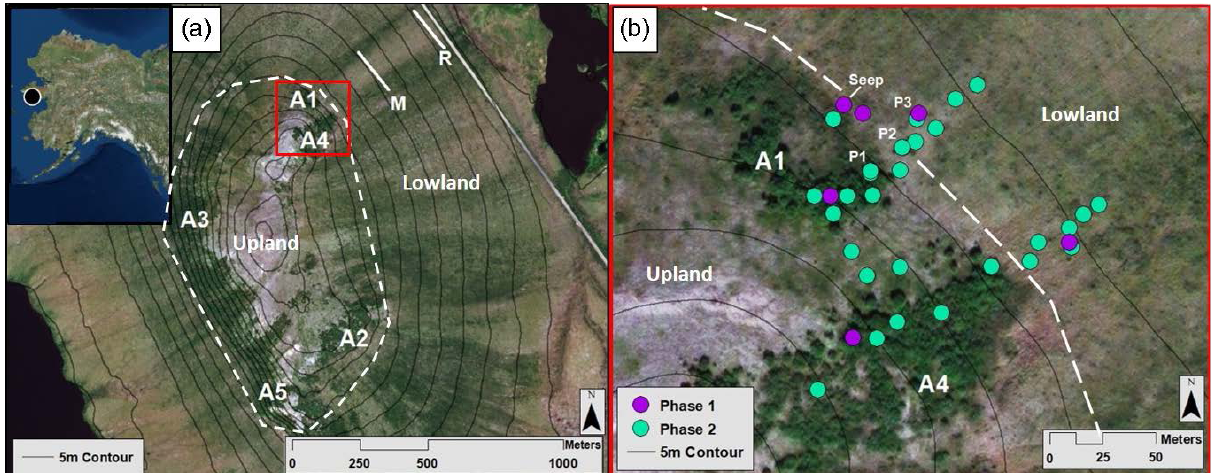
Figure 1. The Kougarok field site and sampling locations. Upper left inset map indicates the location of the Kougarok field site (denoted by a black circle) approximately 80km inland from the town of Nome on the Seward Peninsula, AK. (a) Alder patch and transect locations at the Kougarok hillslope. Solid white lines represent middle (M) and road (R) sampling transects. Dashed white line represents the boundary between the upland area and the lowland area. (b) Higher-resolution map (corresponding to the red box in Fig. 1a) of the spatial sampling locations within the A1 and A4 transects. Phase 1 (July 2017) locations are denoted by purple dots. Green dots indicate additional locations sampled during Phase 2 (September 2017, July 2018, and September 2018). P1, P2, and P3 indicate pit locations dug in July 2018. Dashed white line represents the boundary between the upland area and the lowland area. Aerial imagery in this figure are sourced from Esri, DigitalGlobe, GeoEye, Earthstar Geographics, CNES/Airbus DS, USDA, USGS, AeroGRID, IGN, and the GIS User